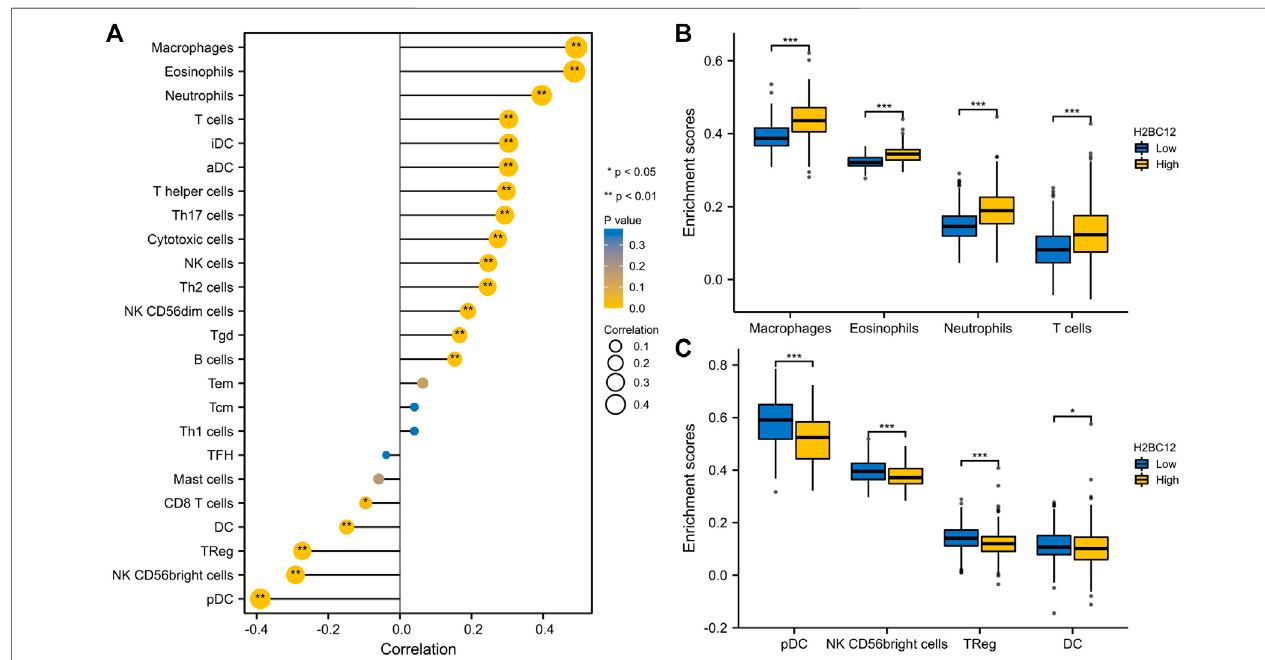
FIGURE 6 | Correlation analysis between H2BC12 and immune in fi ltration. (A) Association analysis between H2BC12 expression and immune cells. (B, C) Differences in immune cell in fi ltration levels between high and low H2BC12 expression groups.